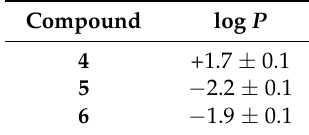
Table 2. Distribution coefficients of the compound 4 – 6 between Phosphate-Buffered Saline (PBS) and octanol. Average of three independent measurements.